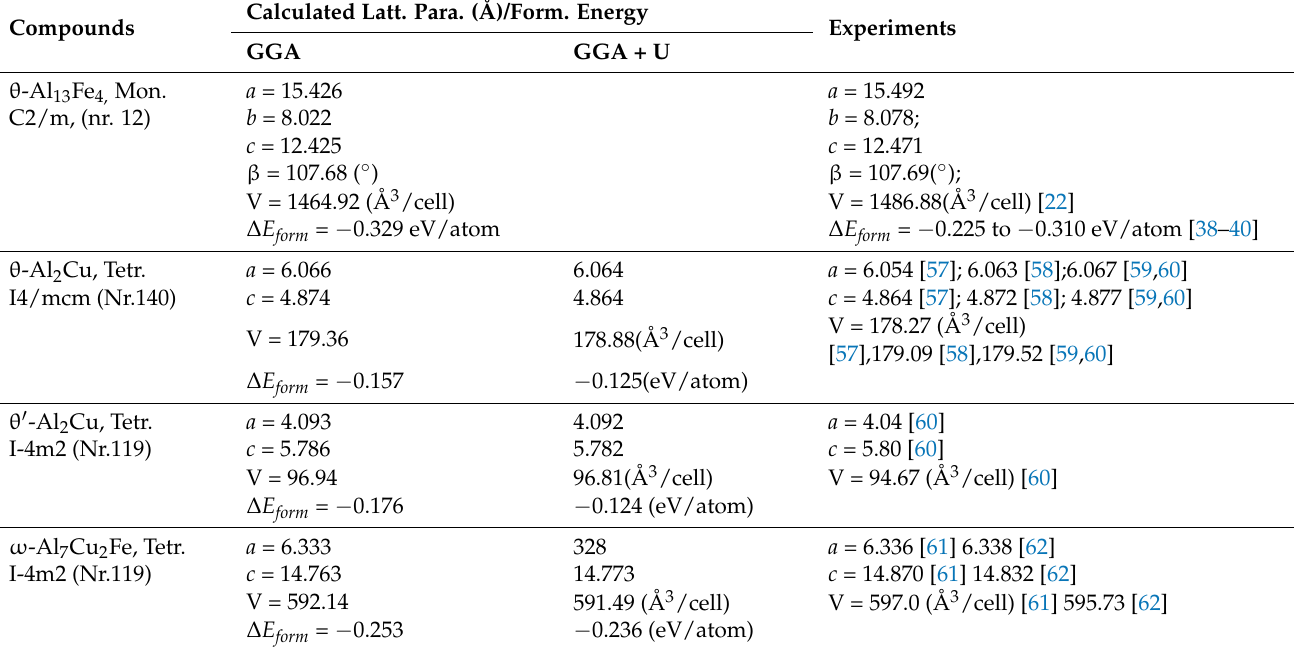
Table 2. Calculated results (lattice parameters, formation energies according to Equation (2)) for the stable structure in the binary and ternary systems at ambient conditions. Experimental data in the literature are included for